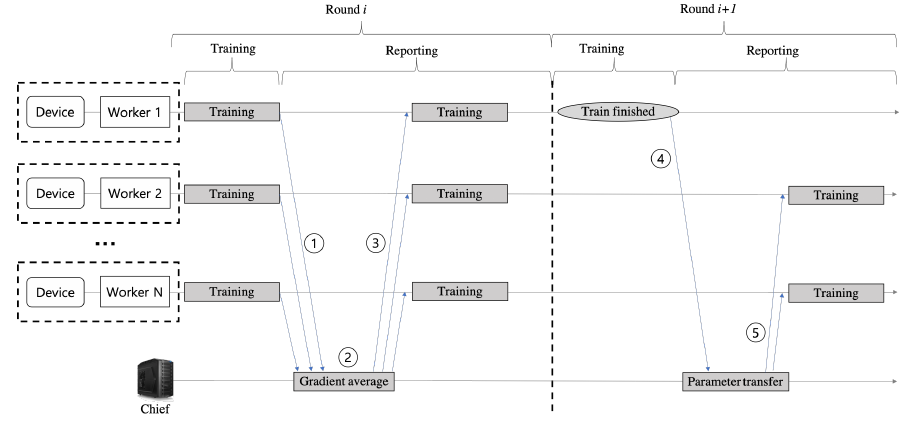
Figure 2. The federated reinforcement learning overall